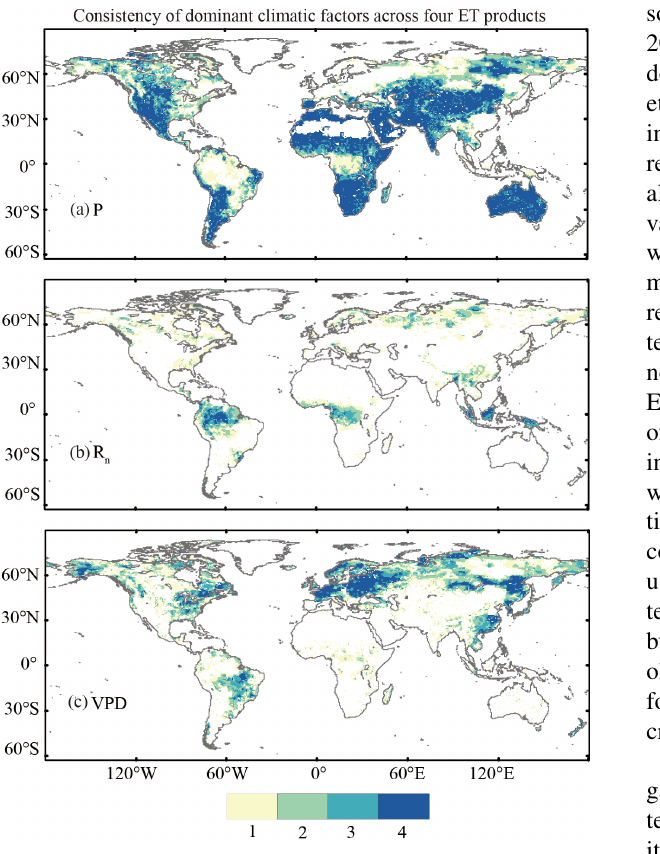
Figure 4. The consistency of spatial distribution of dominant cli- matic factors to global long-term ET trends between GLEAM3.0a, EartH2Observe-En, GLDAS2.0-Noah, and MERRA-Land for pre- cipitation (a) , net radiation (b) , and VPD (c) . The land fraction of air temperature ( T 1 ) and wind speed is limited, and the two fac- tors’ results are not shown here. Numbers 1–4 represent the count of these models with the same dominant factor in one pixel, and indicate different confidence levels from low to